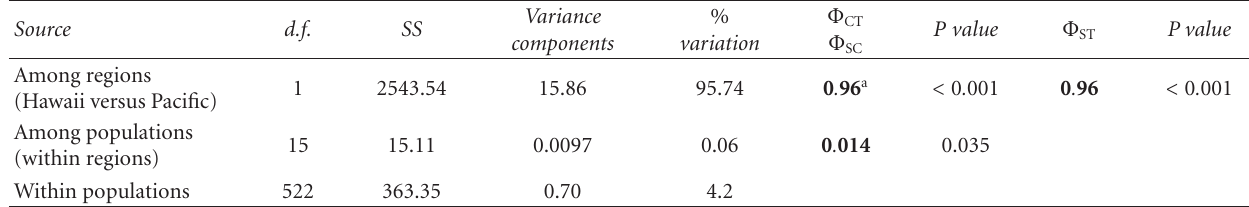
Table 2: Genetic structuring (Analysis of Molecular Variance, AMOVA) of Acanthurus nigroris sampled at sites throughout the Pacific populations were divided into two separate groups to assess the relationship between these regions. Φ CT : region variance component relative to total variance; Φ SC : between population within region variance component divided by the sum of itself and within population variance; Φ ST : sum of the variance due to region and population within region divided by the total